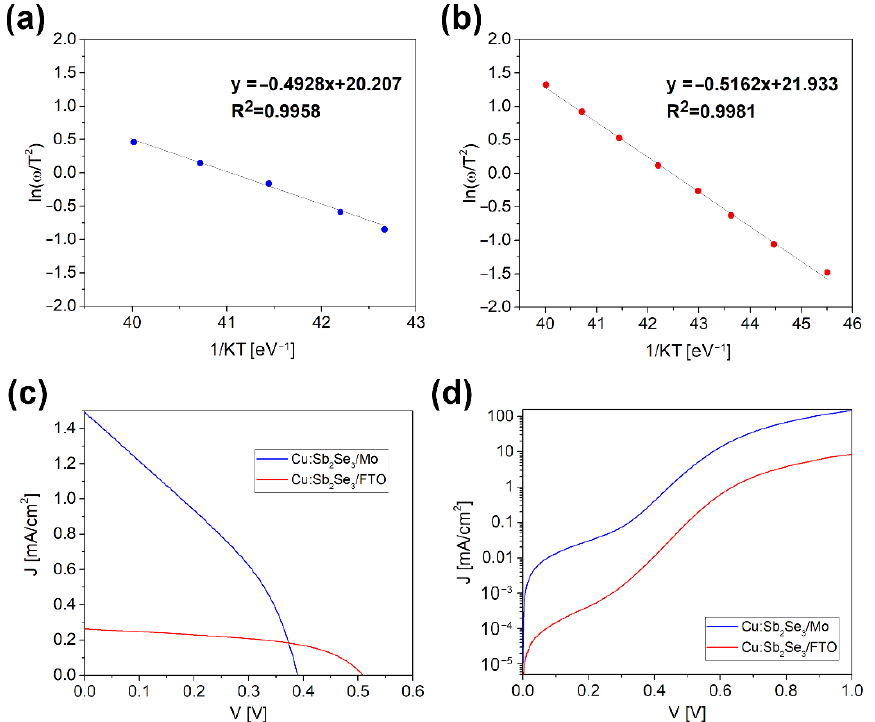
Figure 6. Electrical characterization of the two cells with Cu-doped Sb 2 Se 3 on Mo (Glass/Mo/Cu:Sb 2 Se 3 /CdS/ZnO/AZO) and on FTO (Glass/FTO/Cu:Sb 2 Se 3 /CdS/ZnO/AZO) with the highest recorded Voc values: Arrhenius plots of ln (w/T 2 ) vs 1/KT calculated from the C vs w spectra in the 250K-300K temperature range for the cell on Mo ( a ); and on FTO ( b ). J-V plot for the two cells under illumination ( c ); and in the dark ( d ).